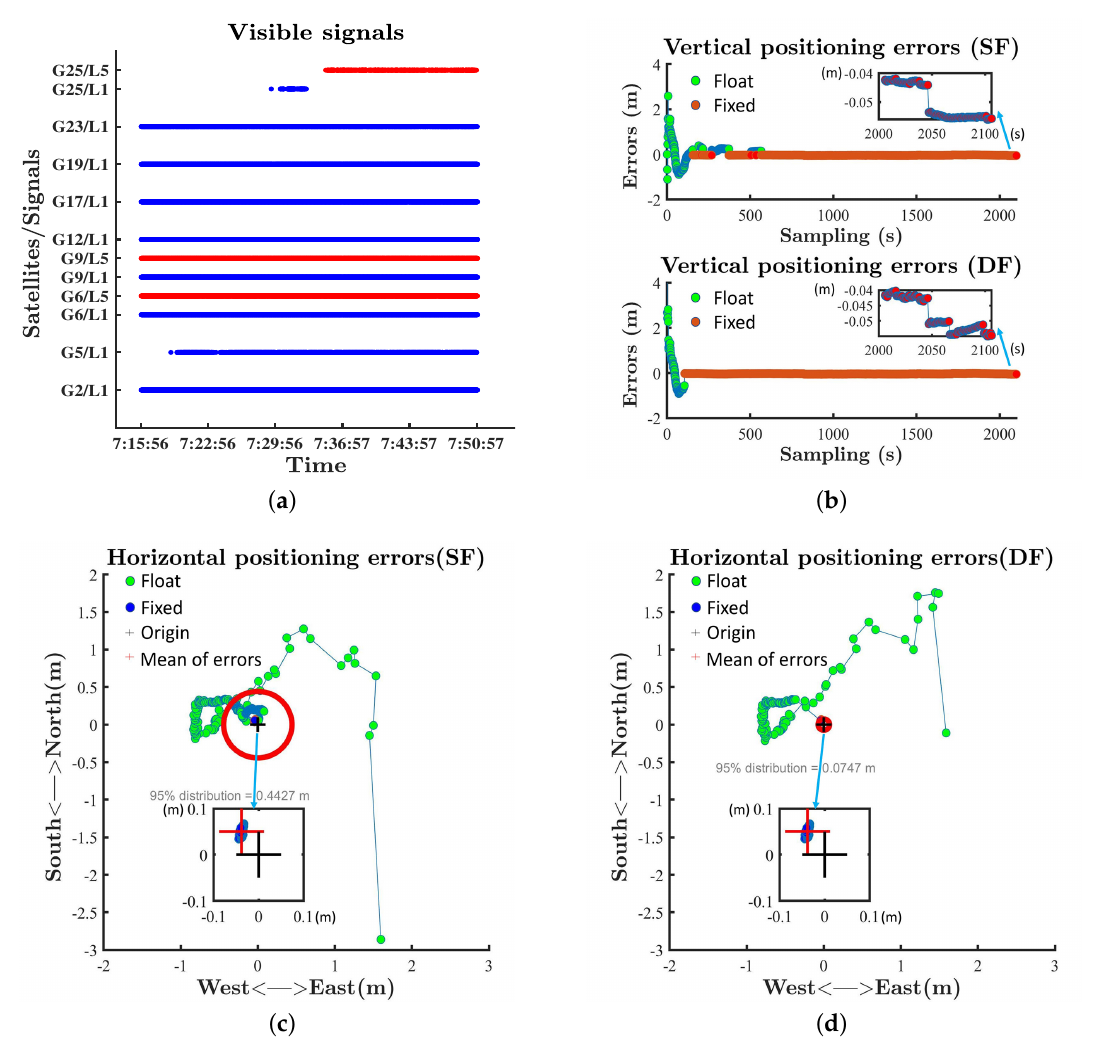
Figure 4. RTK performances in static mode. ( a ) The visible signals; ( b ) vertical positioning errors; ( c ) horizontal positioning errors (single frequency); ( d ) horizontal positioning errors (dual